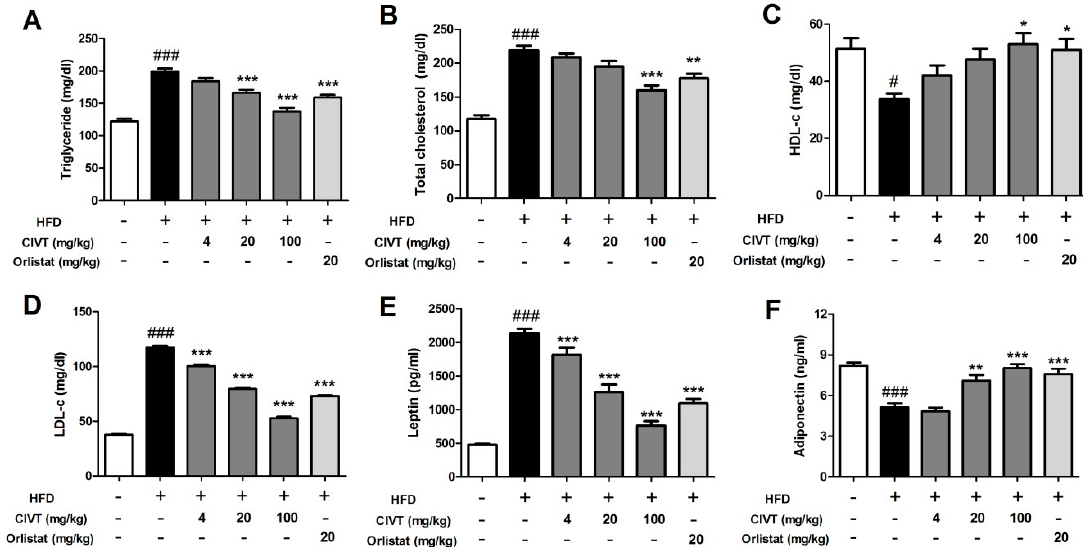
Figure 2. Effects of CIVT on serum levels of biochemical parameters in HFD-fed obese mice. After the 7-week experimental period, serum levels of Triglyceride ( A ), Total cholesterol ( B ), HDL-c ( C ) and LDL-c ( D ) were measured using commercial kits. Serum levels of Leptin ( E ) and Adiponectin ( F ) were measured using ELISA. Values represent the means ± SEMs ( n = 6). Data were analysed by Bonferroni correction for post-hoc test. ### p < 0.001 versus the ND group; * p < 0.05, ** p < 0.01 and *** p < 0.001 versus the HFD